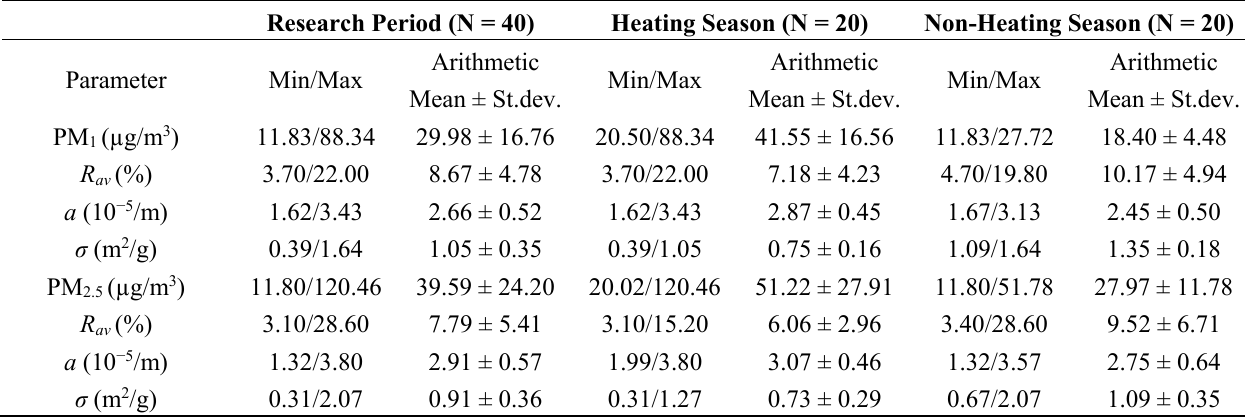
Table 3. Statistics for the optical parameters of PM 1 and PM 2.5 at UT (urban traffic site). Research Period (N = 40) Heating Season (N = 20) Non-Heating Season (N = 20) Arithmetic Parameter Min/Max Mean ± St.dev.